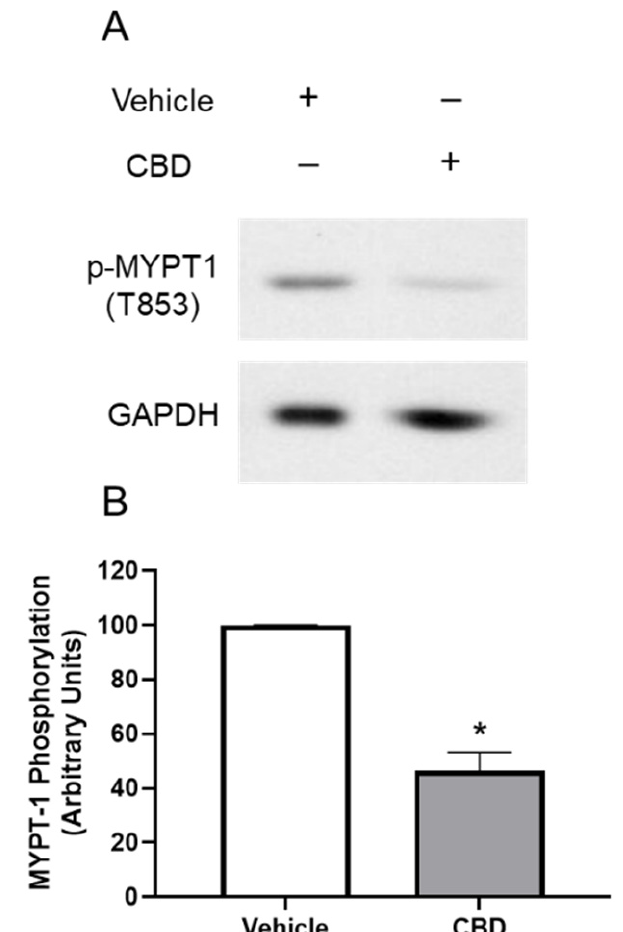
Figure 4. Effect of cannabidiol on myosin phosphatase targeting subunit 1 (MYPT1) phosphoryla- tion. ( A ): Western blot representative of phosphorylation of myosin phosphatase targeting subunit 1 (MYPT1) at Thr853 for three experiments is shown. TM cells were serum starved overnight and treated with vehicle or 1 µM CBD for 2 h, then phosphorylation of MYPT1 at Thr853 was assessed. ( B ): densitometry quantification of phospho-MYPT1 from three experiments is shown. Following treatment with CBD, MYPT1 phosphorylation at Thr853 significantly decreased. Results are ex- pressed as mean ± SEM ( n = 3). Vehicle treated phosphorylation of MYPT1 levels are normalized to 100%. * Significant difference from vehicle determined by t -test, p < 0.05.